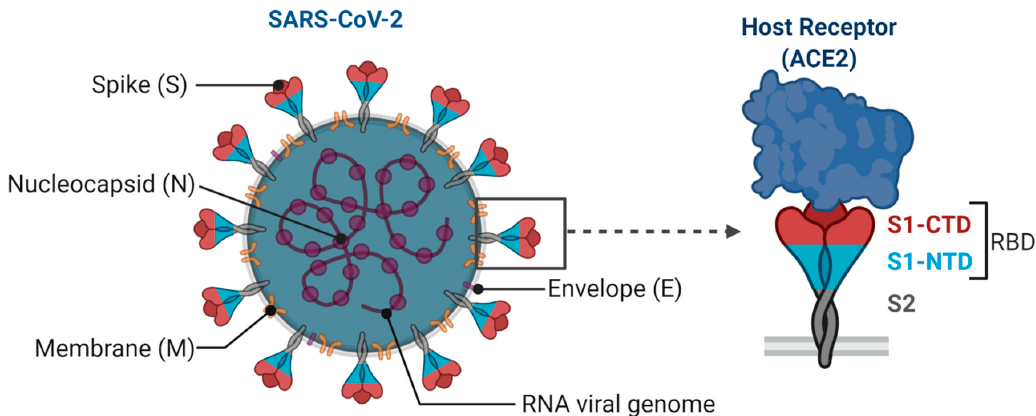
Figure 1. Structural features of SARS-CoV-2. Spike (S) glycoprotein, the membrane (M) protein, and envelope (E) protein are embedded in the viral envelope. The RNA genome is complexed with the nucleocapsid (N) protein. Virus spike trimer is enlarged to depict its key subunits (S1 and S2) and N-terminal domains (NTD) and C-terminal domains (CTD) in the S1 subunit encompassing receptor-binding domain (RBD). S protein targets the host cell receptor, ACE2, through RBD in S1 subunit (Created with Biorender.com).